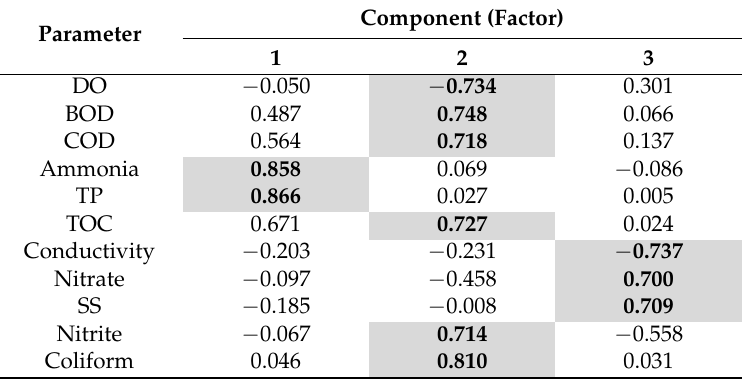
Table 6. Contribution percentage of each factor from MLR results.